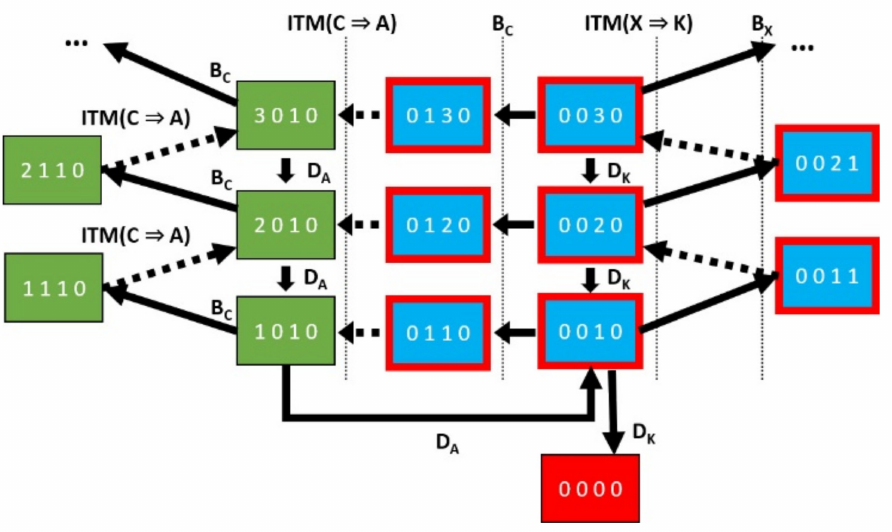
Figure 14. Simplified Dynamic TBRM for the example task in a MAS implementing the